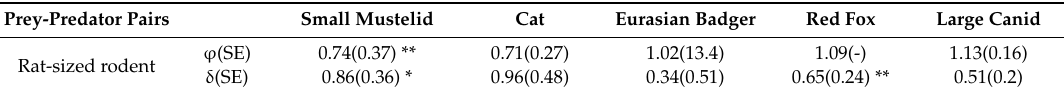
Table 3. Parameters of interspecific interactions between rat-sized rodents and predators representing the deviation from randomness of the probability of species co-occurrence in a crossing structure ( ϕ ) or on a given day ( δ ). Standard errors are given in parentheses, except where not computed due to a lack of variability at some passage types. * p < 0.05 and ** p < 0.01.